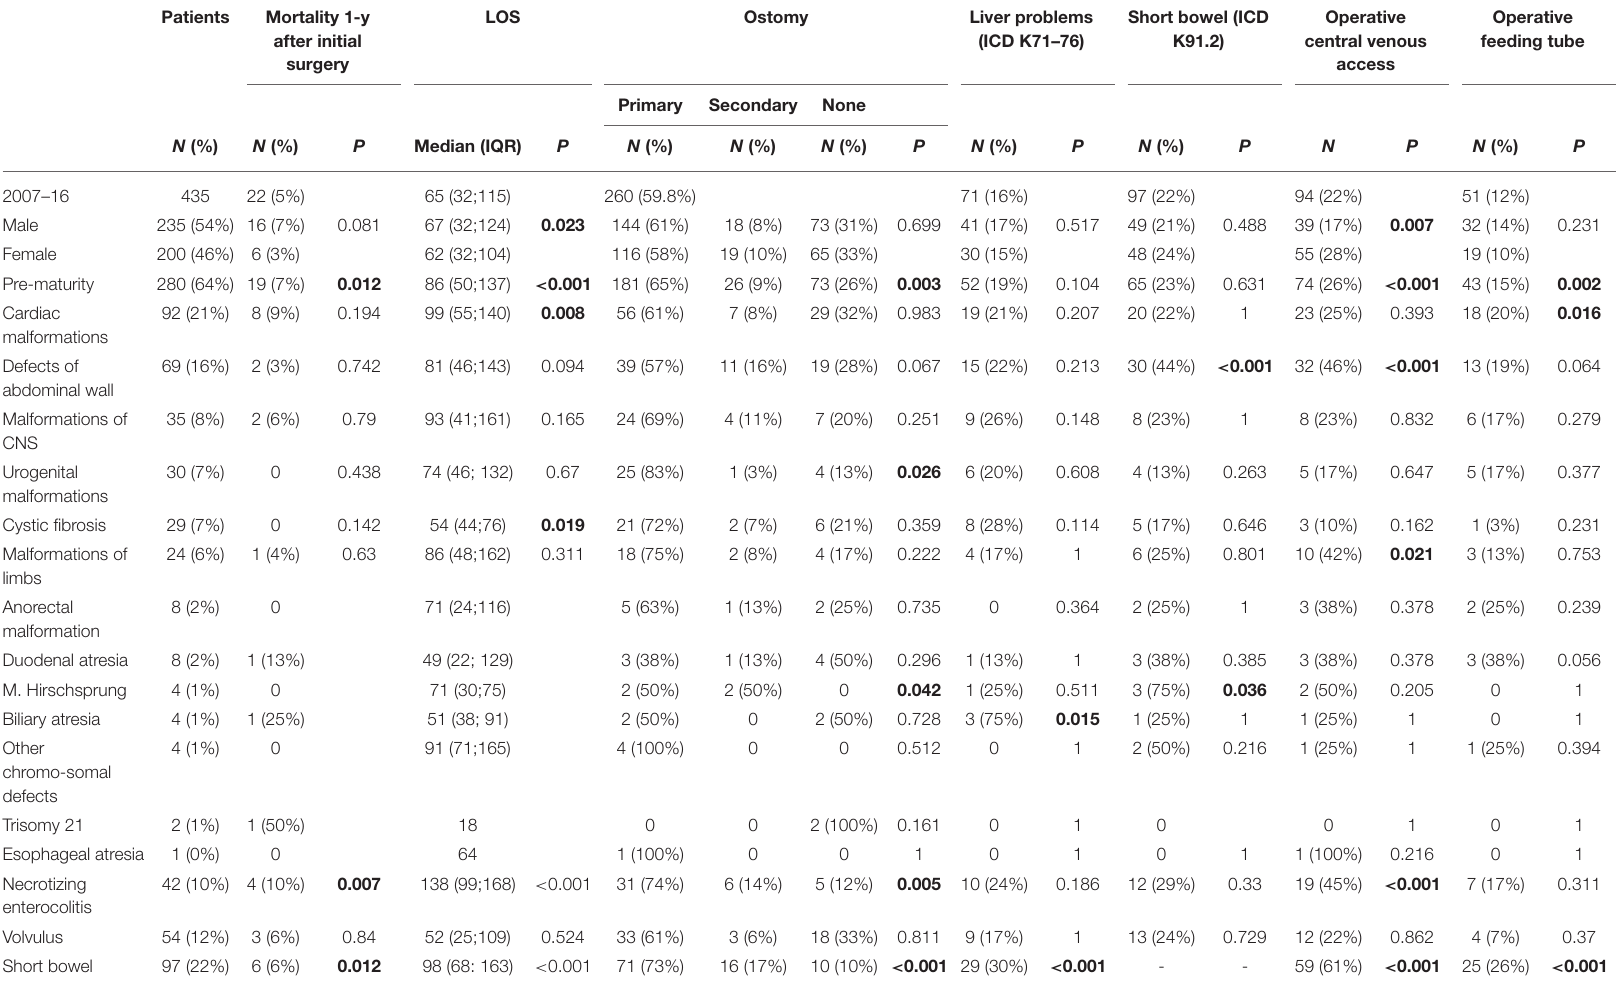
TABLE 1 | Associated anomalies, pre-maturity of the children with atresia of small bowel together with outcome